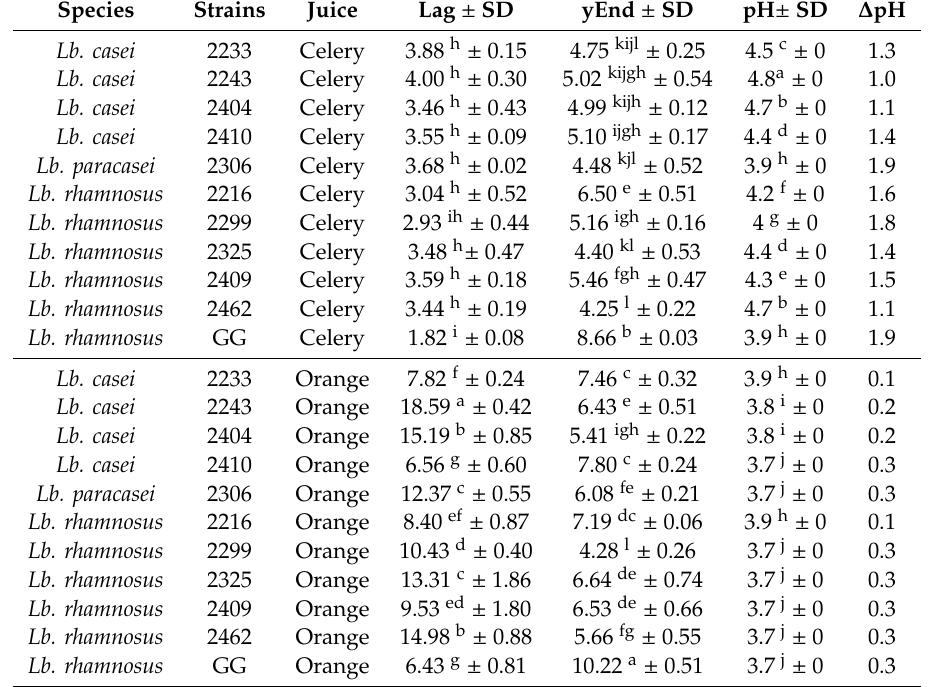
Table 3. Results of the impedometric measurements reported as mean value ± SD, for each strain in both the substrates